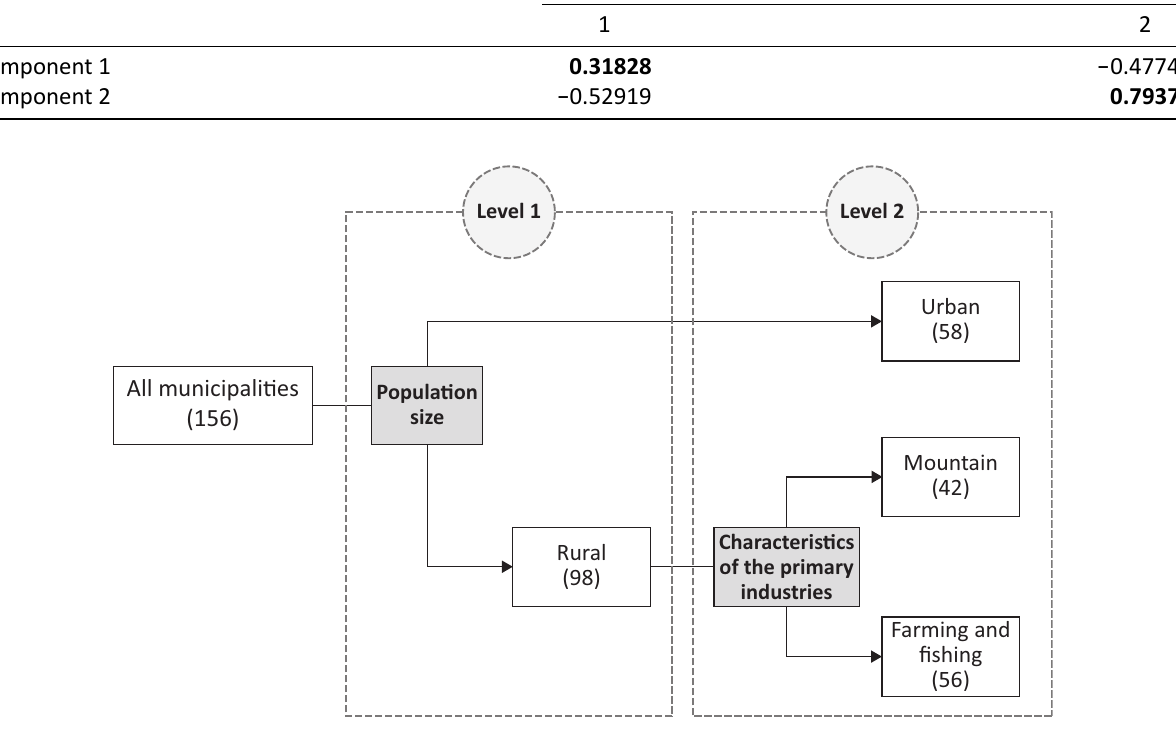
Figure 3. Result of classification of municipalities. Table 6. Description of the scale of pairwise